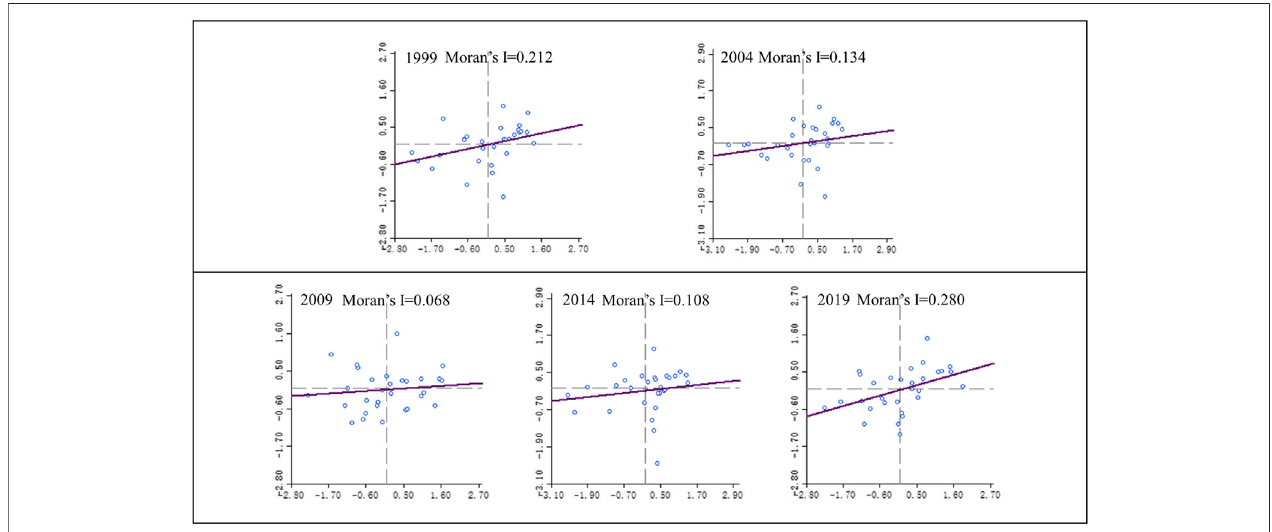
FIGURE 9 | Moran ’ s I dispersion for fi re situation in